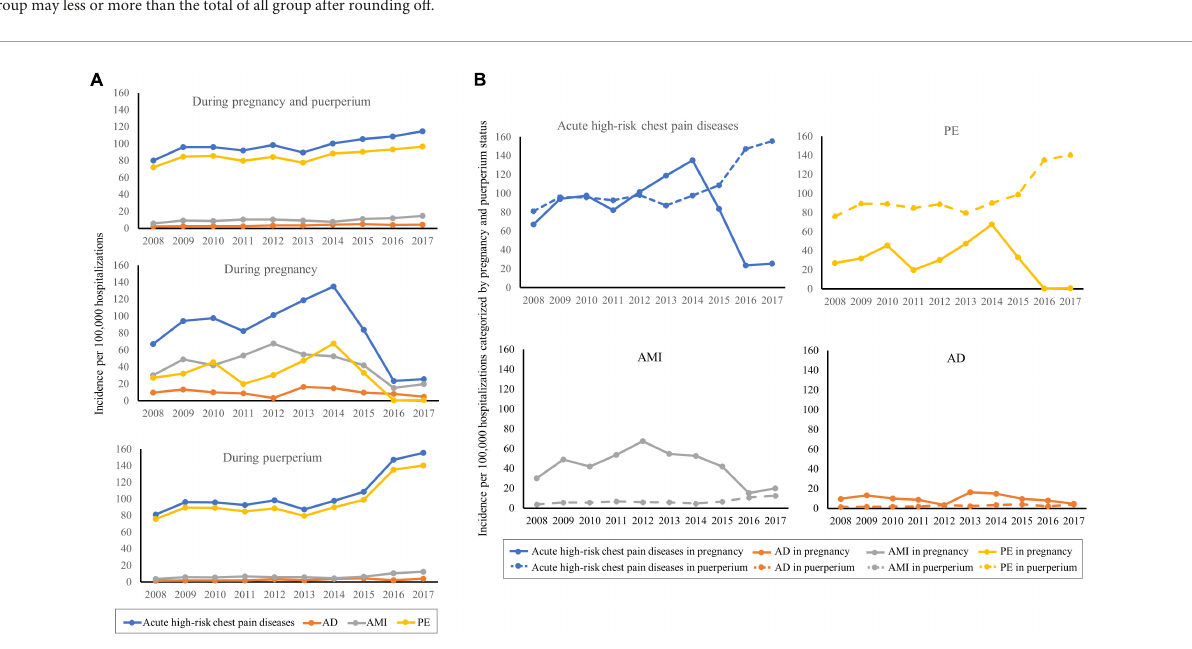
FIGURE2 Temporal trends of the incidence in acute high-risk chest pain diseases during pregnancy and puerperium. (A) Temporal trends during pregnancy and puerperium, during pregnancy, and during puerperium, respectively (All P trend < 0.0001). (B) Temporal trends of the incidence in acute high-risk chest pain diseases, PE, AMI, and AD categorized by pregnancy and puerperium status (All P trend <